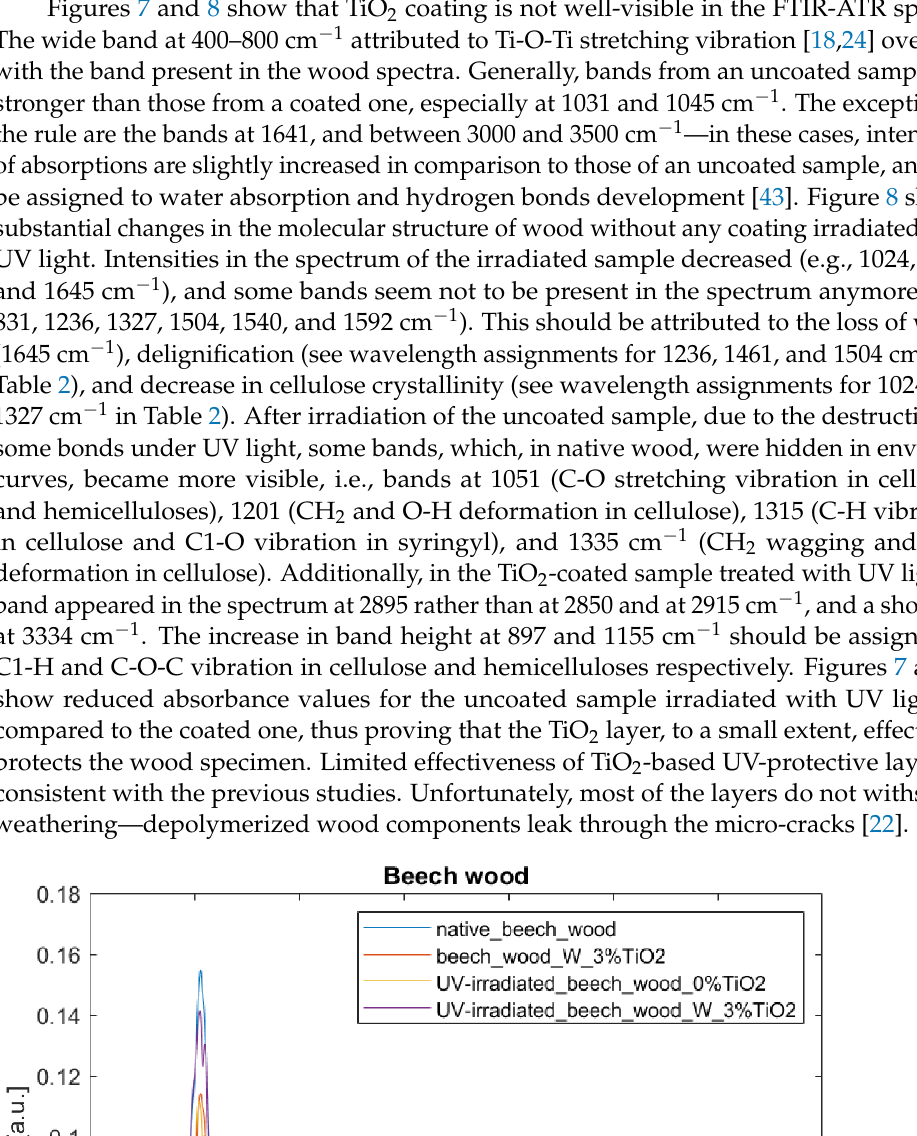
Figure 8. FTIR-ATR spectra of beech wood samples in the fingerprint region 800 – 1800 cm − 1 : (blue) reference sample of native beech wood, (red) beech wood with 3% TiO 2 coating with water as